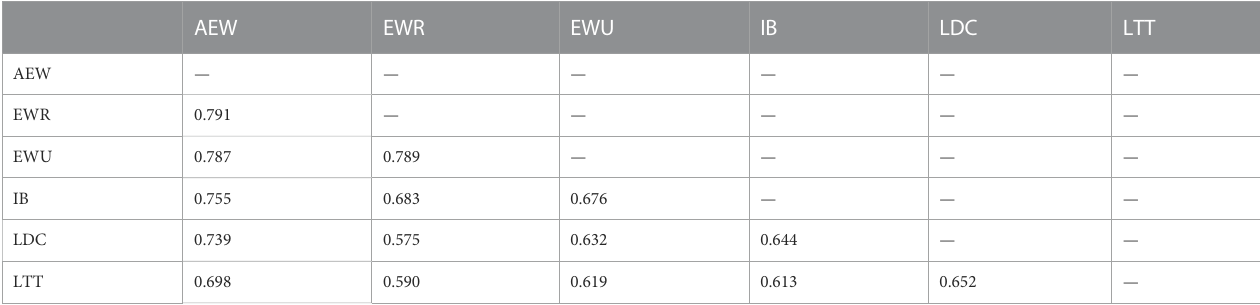
TABLE 2 Discriminant validity